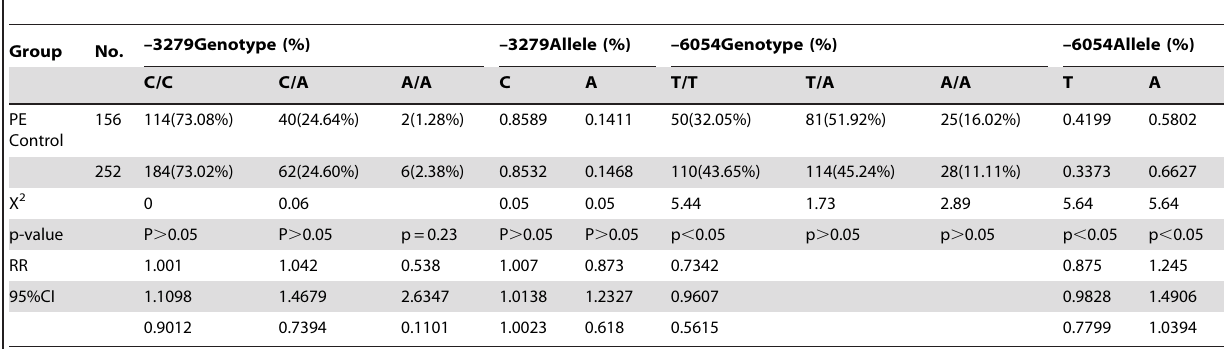
Table 3. Allele and genotyping frequencies of Foxp3-3279 and -6054 in PE and control groups.